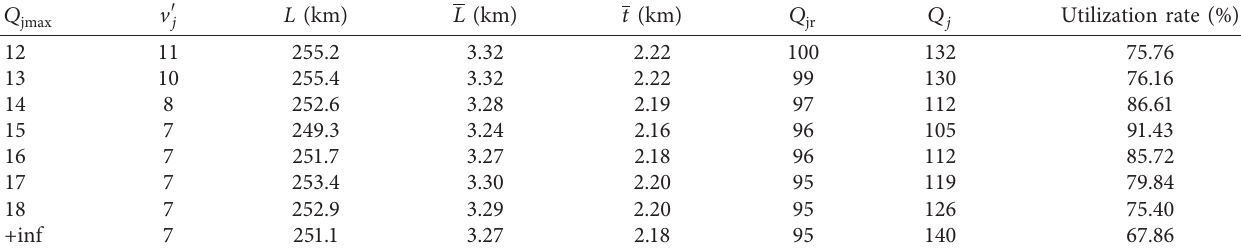
on model solutions. jmax